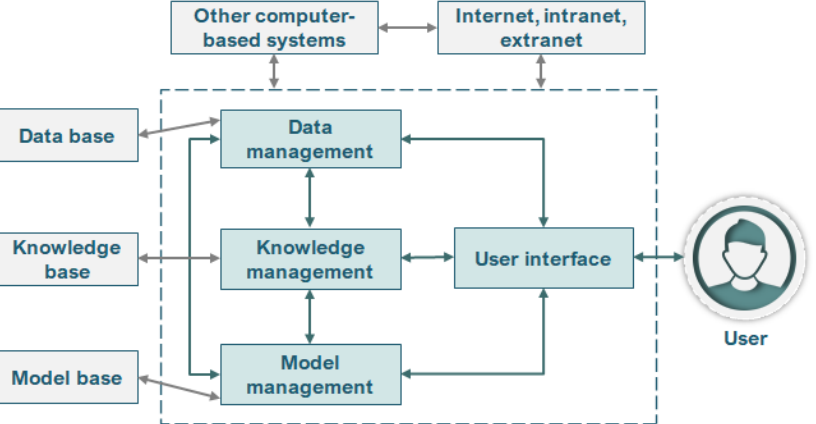
Figure 5. General structure of a decision support system, consisting in four components: data, model, knowledge management and user interface (based on [64]).